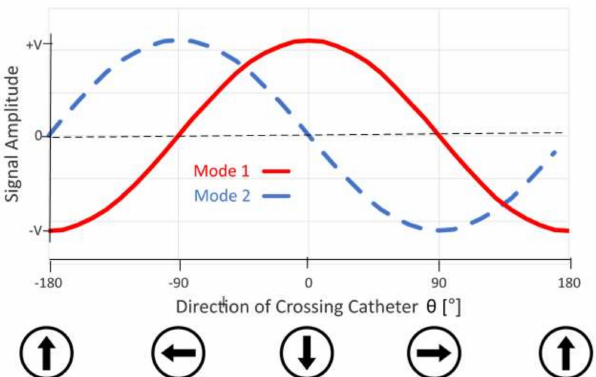
Figure 4. Angular dependence of received signal amplitude at a constant distance from the crossing catheter as a function on alignment angle relative to the target device. Mode 1: driven in “front–back” mode. Mode 2: driven in “left–right”